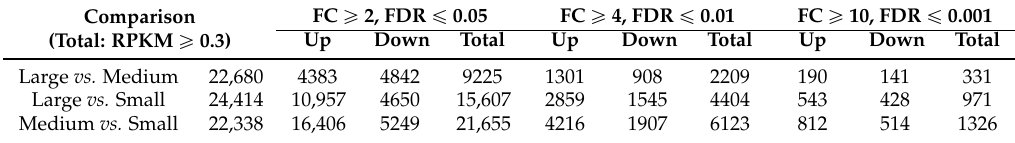
Table 2. Genes showing differential expression between small and large abalones. Differentially-expressed transcripts were determined from comparisons of the RPKM values of genes in large vs. medium, large vs. small, and medium vs. small Pacific abalones. Numbers were obtained using two-, four-, and 10-fold change (FC) cut-off values, and the FDR threshold is indicated. Comparison (Total: RPKM ě